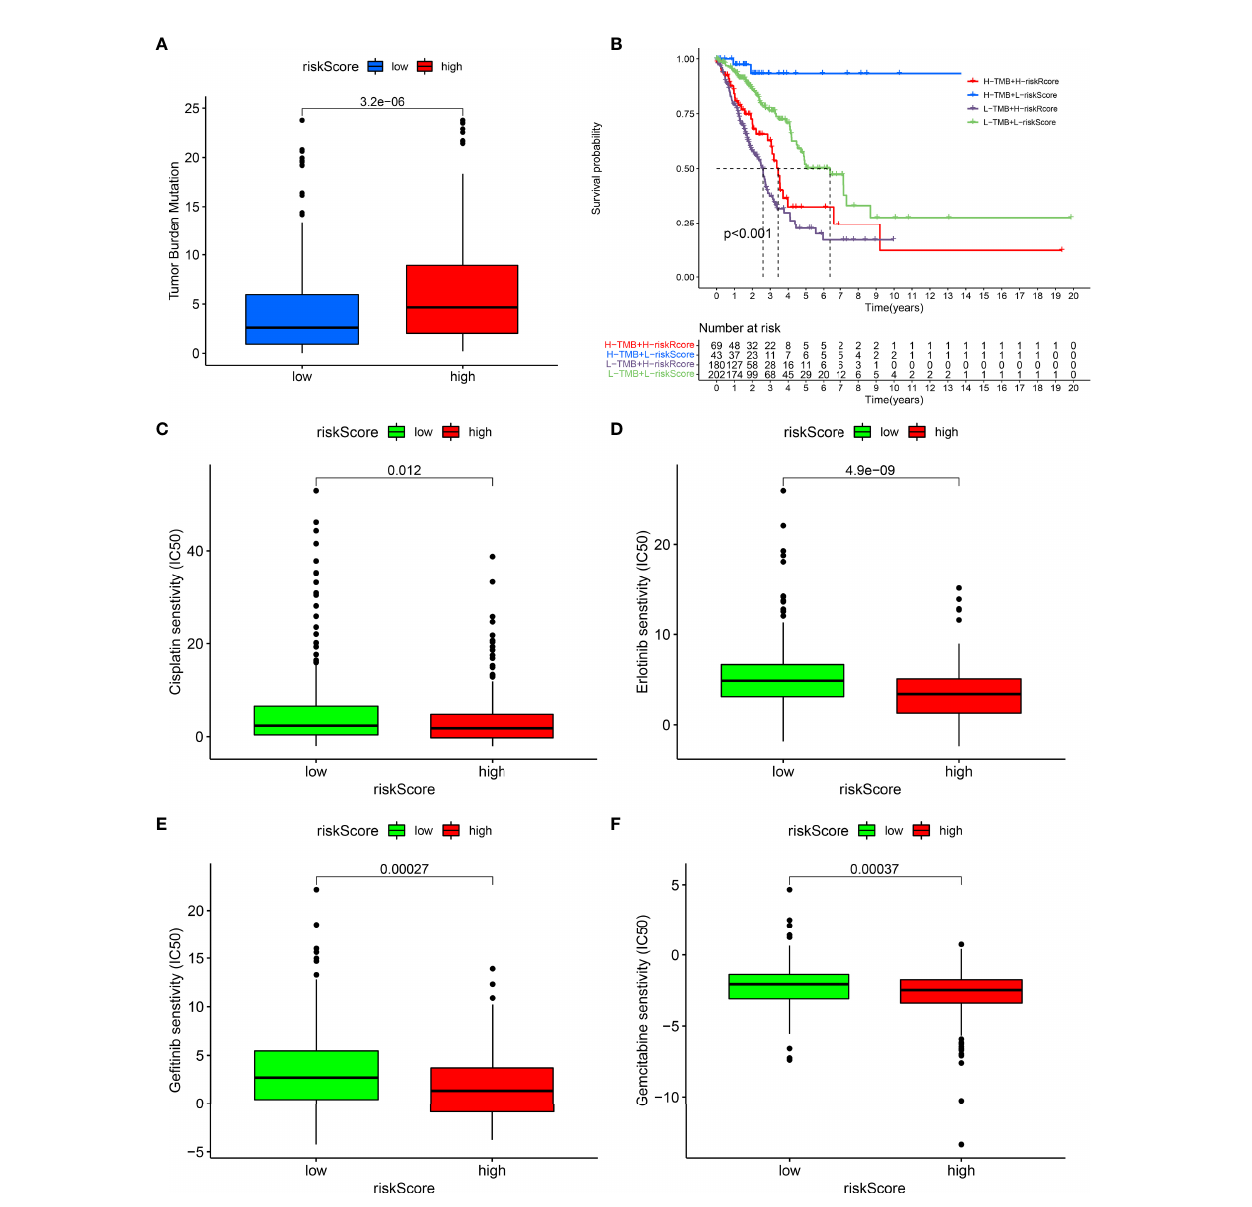
FIGURE 6 | Associations of prognostic model with TMB and drug responses. (A) Comparisons of TMB score between high- and low-risk groups. (B) Survival analysis of different TMB score and risk score groups. (C – F) Comparisons of sensitivity to cisplatin, erlotinib, ge fi tinib, and gemcitabine between high- and low- risk